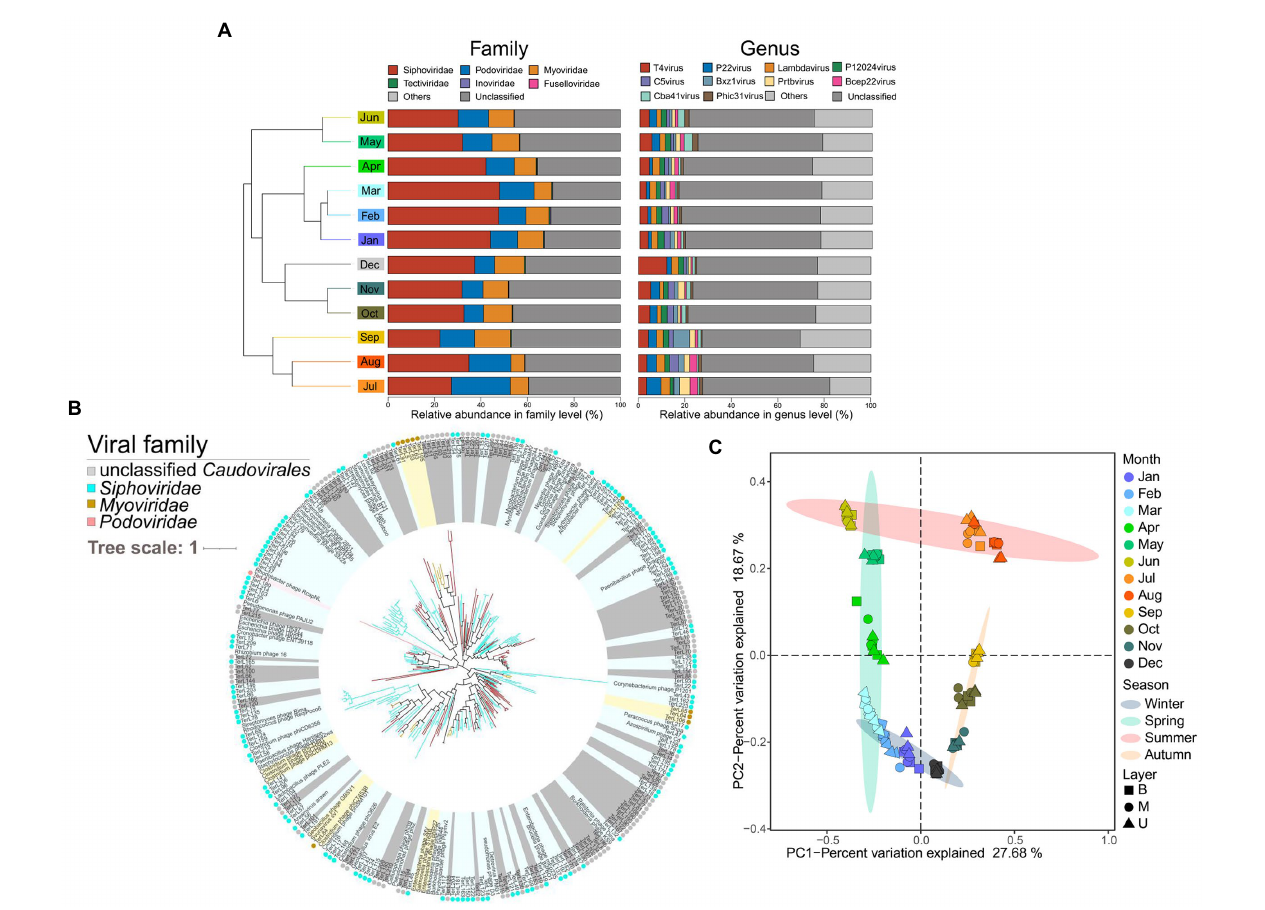
FIGURE 6 Overview of the viral communities in the EGSB. (A) Composition of the viral community-based at family and genus level. Samples are collapsed and colored by month and clustered based on their Bray–Curtis distances. (B) Phylogenetic tree based on the terL gene of Caudovirales . The Viral family-specific protein marker terL gene is used to construct phylogenetic trees with references downloaded from viral RefSeq for Caudovirales . Light yellow, light blue, light pink, and gray nodes and circles outside represent Myoviridae , Siphoviridae , Podoviridae , and unclassified Caudovirales , respectively. The branches of undetermined viruses are colored red. (C) PCoA of viral communities in anaerobic activated sludge based on Bray–Curtis distances. Different color represents the sampling month and different symbol represents the sampling layer of the